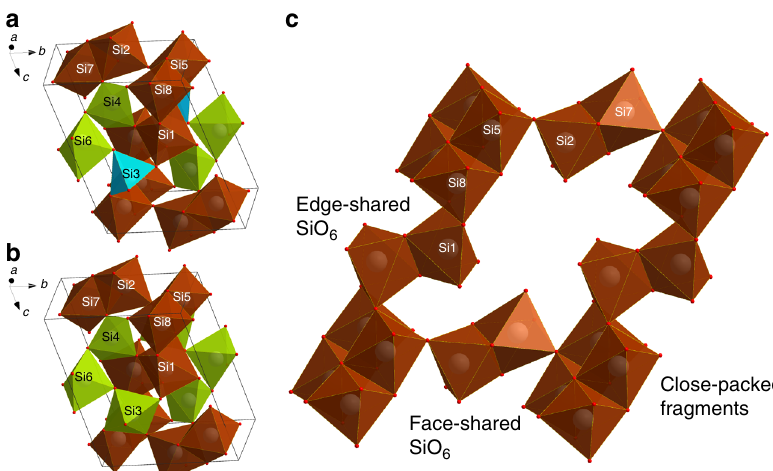
Fig. 2 Crystal structures of coesite-IV and coesite-V. Polyhedral models of the structures of coesite-IV ( a ) and coesite-V ( b ) (SiO 6 octahedra are brown; SiO 5 polyhedra are green; SiO 4 tetrahedra are blue); a fragment of the structures, similar for both coesite-IV and coesite-V, showing a three-dimensional framework of SiO 6 octahedra ( c